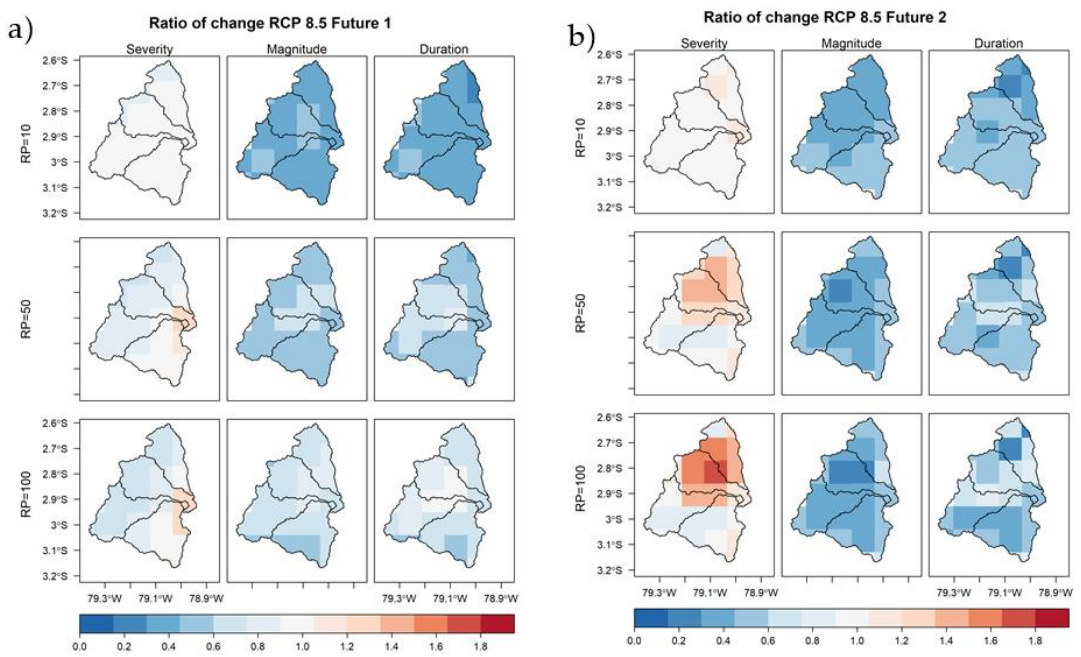
Figure 7. Ratio change of drought features of scenario RCP 8.5 with respect to the base period (1981–2005): ( a ) Future 1 (2011–2040) and ( b ) Future 2 (2041 – 2070).